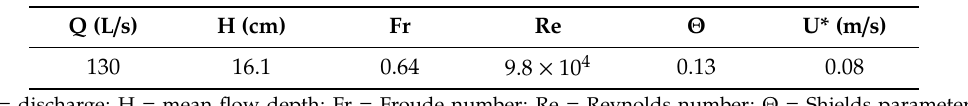
Table 2. The hydraulic parameters of the